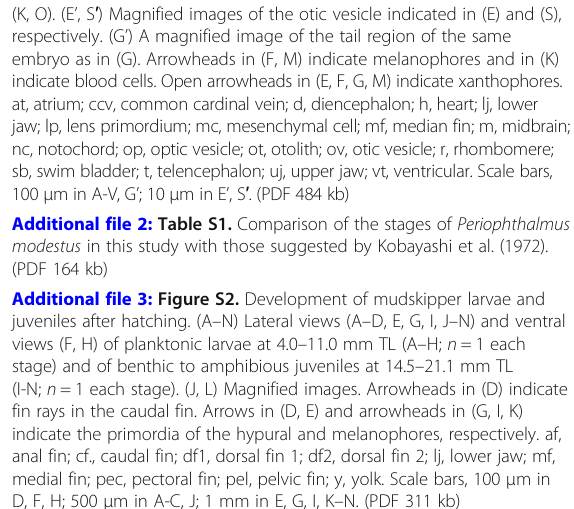
Additional file 1: Figure S1. Development of mudskipper embryos before hatching. (A – V) Mudskipper embryos at the otic vesicle stage (A – C; n =2), brain vesicle stage (D – F; n =2), heart chamber stage (G – I); n = 2, circulation stage (J, K; n =2), eye pigmentation stage (L, M; n = 2), middle-pec stage (N, O; n = 2), high-pec stage (P, Q; n = 2), long fin-fold stage (R-T; n =2), and hatching stage (U, V; n =2). Lateral views of the embryo (A, D, G, J, L, N, P, R, U), the head (B, E, S, V), the tail (C, F, I, T), the trunk (H, O, Q), the eye (M), and the posterior region of the yolk